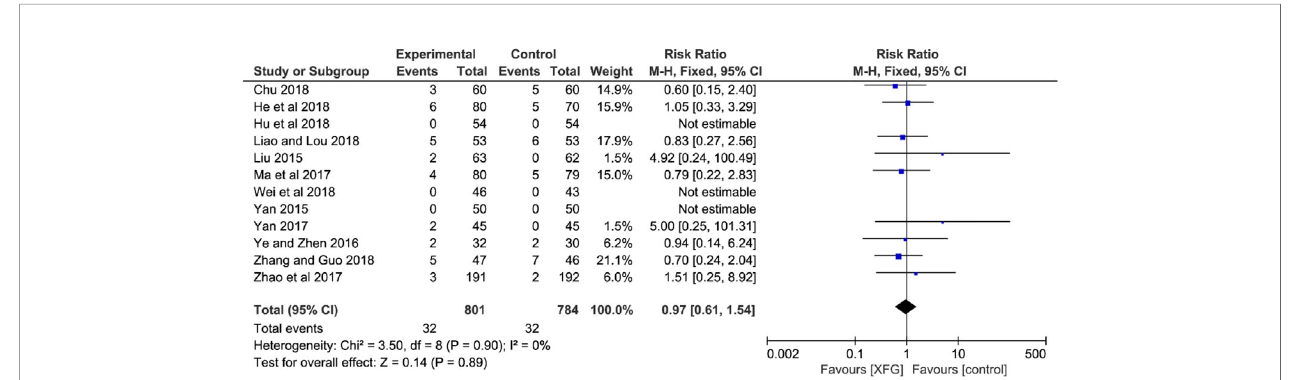
FIGURE 9 | Forest plot and meta-analysis of adverse